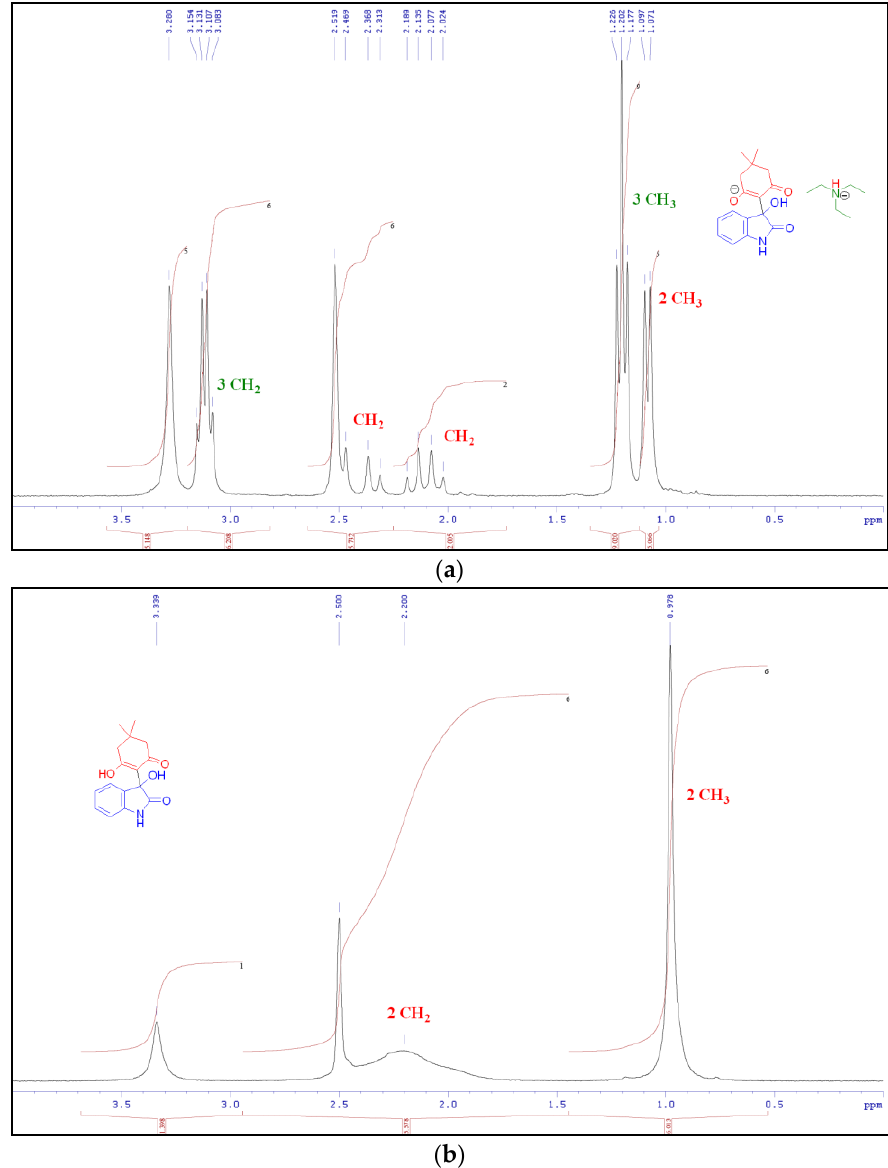
Figure 1. Representative fragments of 1 H-NMR spectra showing changes during the formation of an ion pair for: ( a ) triethylammonium 2-(3-hydroxy-2-oxoindolin-3-yl)-5,5-dimethyl-3-oxocyclohex-1-en-1-olate, 4 ; ( b ) 3-hydroxy-3-(2-hydroxy-4,4-dimethyl-6-oxocyclohex-1-en-1-yl)indolin-2-one, 5 .